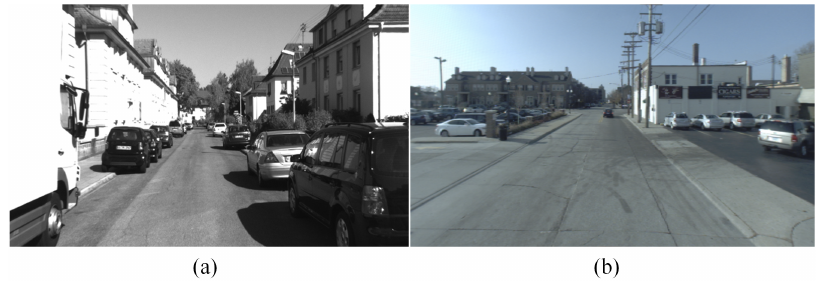
Figure 7. The road boundaries in openly available datasets. ( a ) road boundary is heavily occluded in the KITTI dataset. ( b ) road boundary is missing in many parts of the Ford